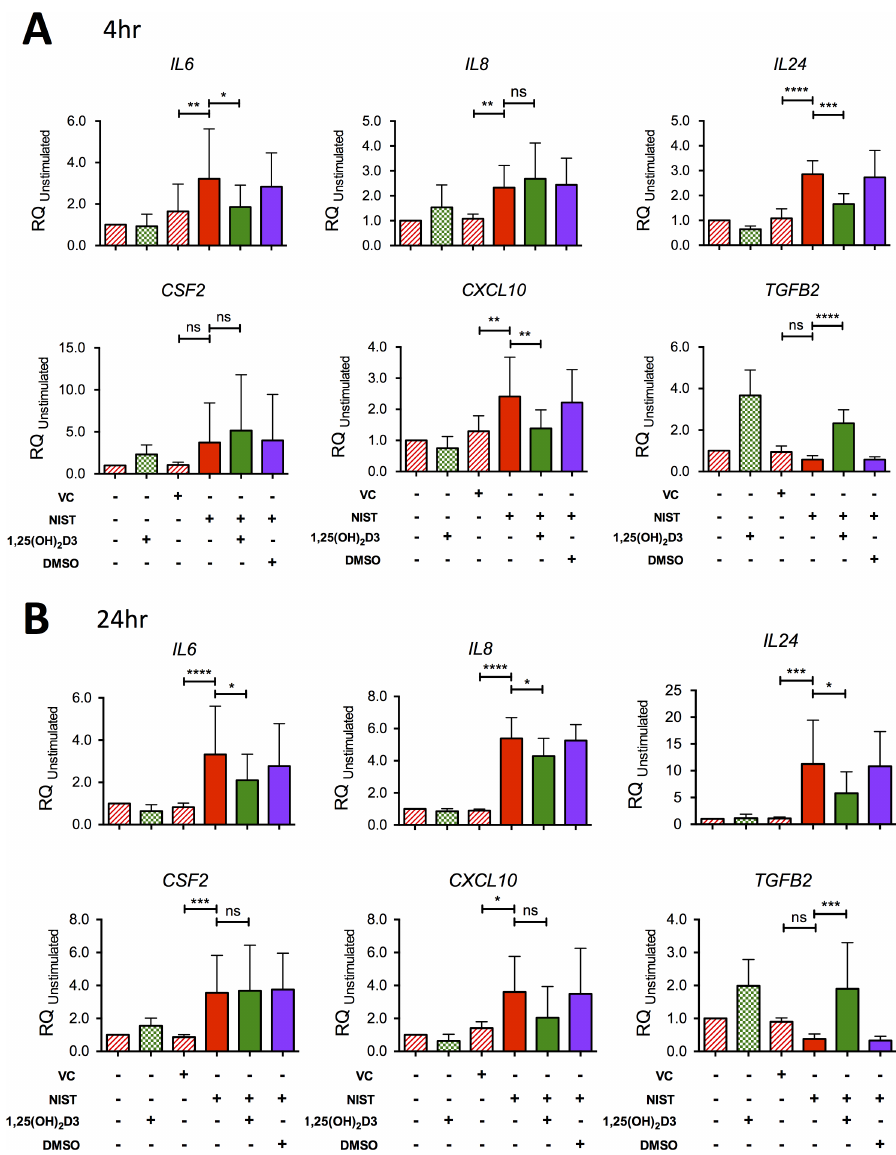
Fig 2. Confirmation by qPCR of the effect of NIST and vitamin D on expression of cytokine genes in HBEC cultures. (A) Gene mRNA expression at 4 hours relative to 18S and the unstimulated Control condition in HBEC cultures stimulated with 50μg/ml NIST in the presence/absence of 100nM 1,25(OH) 2 D3. IL6 , n = 7; IL8 , n = 7; IL24 , n = 6; CFS2 ,n = 8; CXCL10 , n = 6; TGFB2 ,n = 6. (B) mRNA expression at 24 hours. IL6 , n = 9; IL8 , n = 7; IL24 ,n = 6; CFS2 ,n = 8; CXCL10 , n = 6 (one outlying replicate excluded); TGFB2 ,n = 6. All repeated-measures ANOVAs and post-tests with Bonferroni corrections as shown. VC; vehicle control for NIST. Statistical significance as follows: (cid:3) , p (cid:20) 0.05; (cid:3)(cid:3) , p (cid:20) 0.01; (cid:3)(cid:3)(cid:3) , p (cid:20) 0.001; (cid:3)(cid:3)(cid:3)(cid:3) , p (cid:20) 0.0001. a significant difference in the effect of 1,25(OH) D3 on NIST-induced GM-CSF production, 2 from the asthmatic donors. As a result, in NIST-stimulated vitamin D treated cultures induc- HBECs (Fig 3B). There was no significant difference in the effect of vitamin D on CXCL8 pro- duction by HBECs from the non-diseased and asthmatic donors.